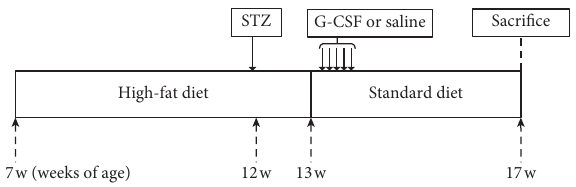
Figure 1: Animal experiment scheme. Sprague–Dawley rats were randomly divided and fed the standard diet (normal control; n � 8) or high-fat diet (HFD; n � 16) for 6 weeks. After 5 weeks of feeding, HFD rats were intraperitoneally injected with low-dose strepto- zotocin (STZ; 30mg/kg). One week later, HFD rats received treatment with either intraperitoneal G-CSF ( n � 8; 200 μ g/kg/day) or saline ( n � 8; the same volume as G-CSF) for 5 consecutive days and were fed the standard diet until the end of experiment. Four weeks after the start of treatment, all rats were sacrificed for